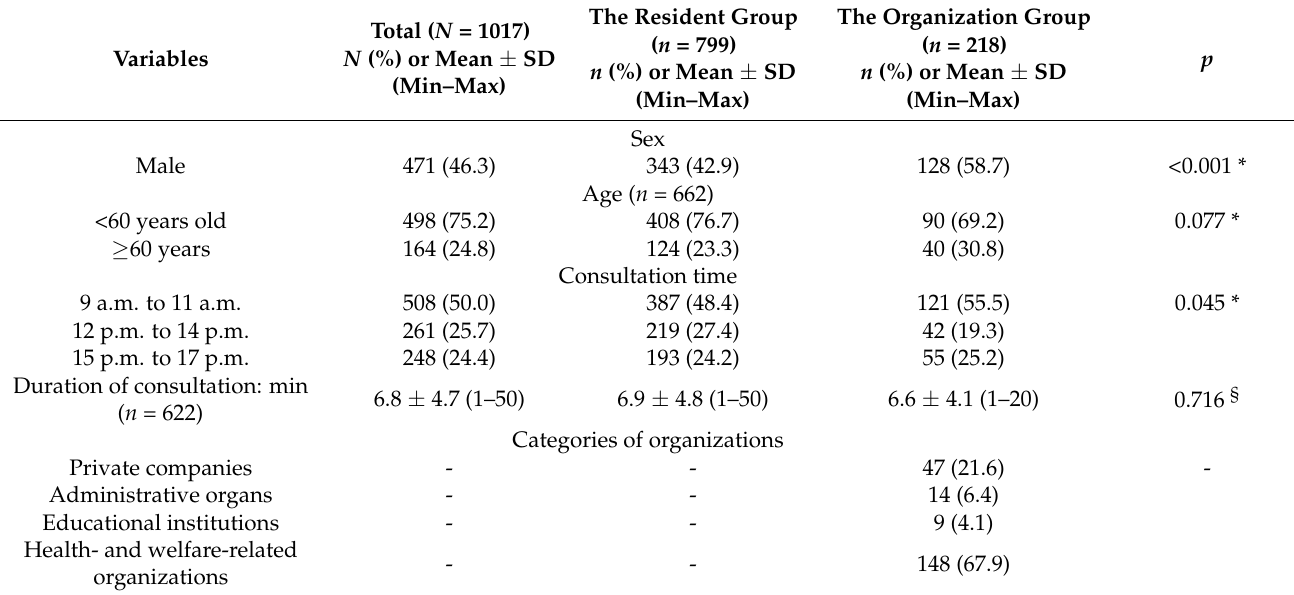
Figure 1. Flowchart of this study. Table 1. Characteristics of COVID-19-related free telephone consultations ( N = 1017).